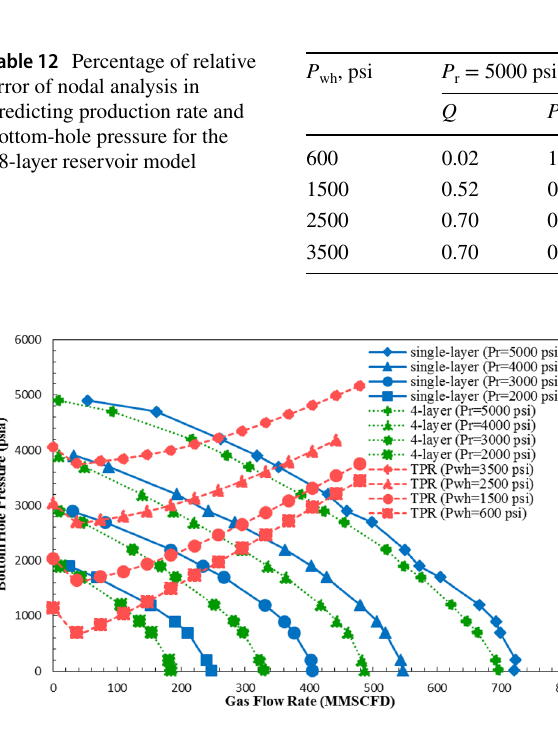
Fig. 9 Nodal analysis for the single-layer and 4-layer reservoir mod- els